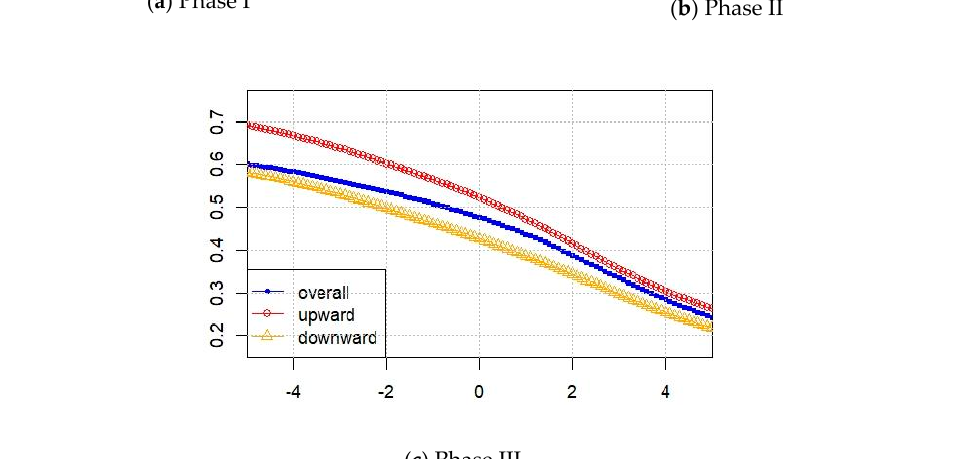
Figure 5. The H ( q ) , H + ( q ) , and H − ( q ) functions in the return dynamics versus q . ( a ) Of Phase I; ( b ) Of Phase II; ( c ) Of Phase III. Figure 5. The (cid:1834)((cid:1869)) , (cid:1834) (cid:2878) ((cid:1869)) , and (cid:1834) (cid:2879) ((cid:1869)) functions in the return dynamics versus (cid:1869) . ( a ) Of Phase I; ( b ) Of Phase II; ( c ) Of Phase III.